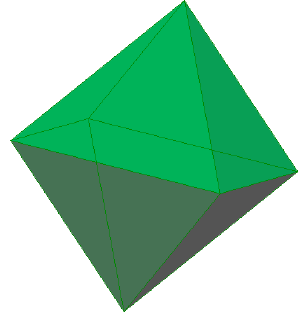
Figure 6. A convex regular octahedron [compiled by the authors]. Its free diameter β cage is 0.66 nm, and its point symmetry is